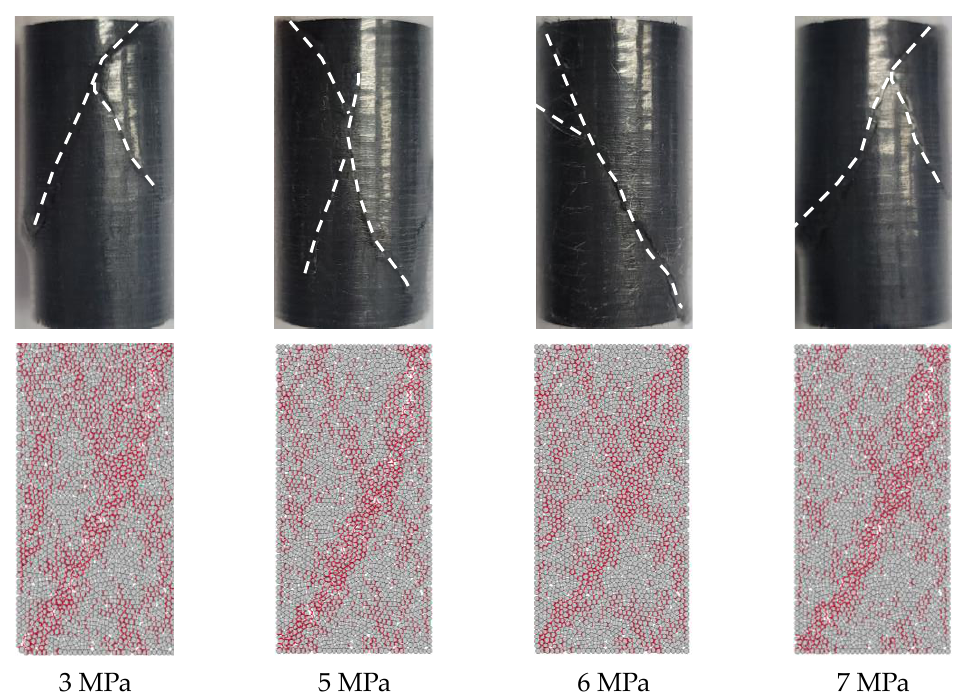
Figure 4. Numerical and experimental cracks under different confining pressures.